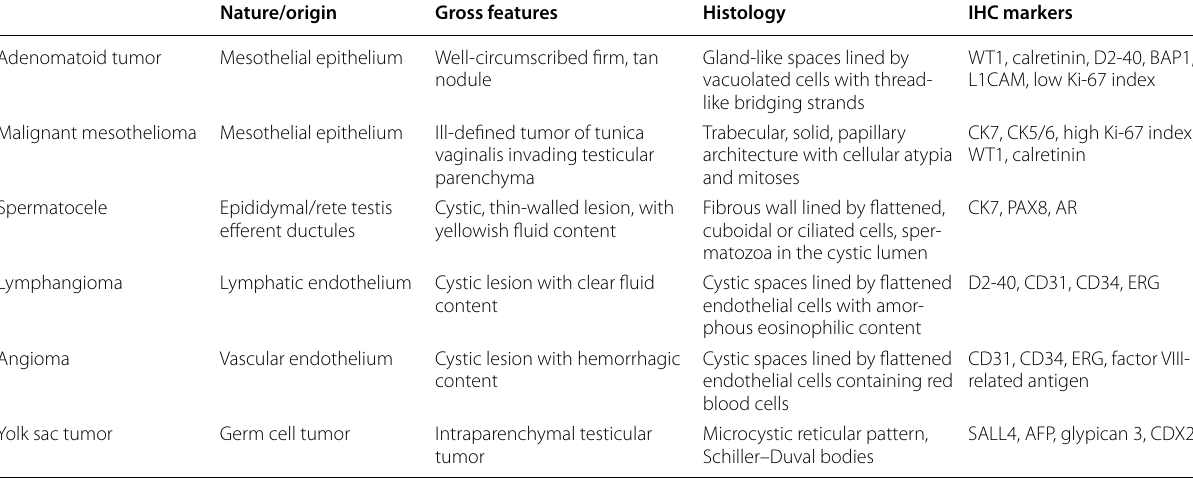
Table 1 Main differential diagnoses of testicular adenomatoid